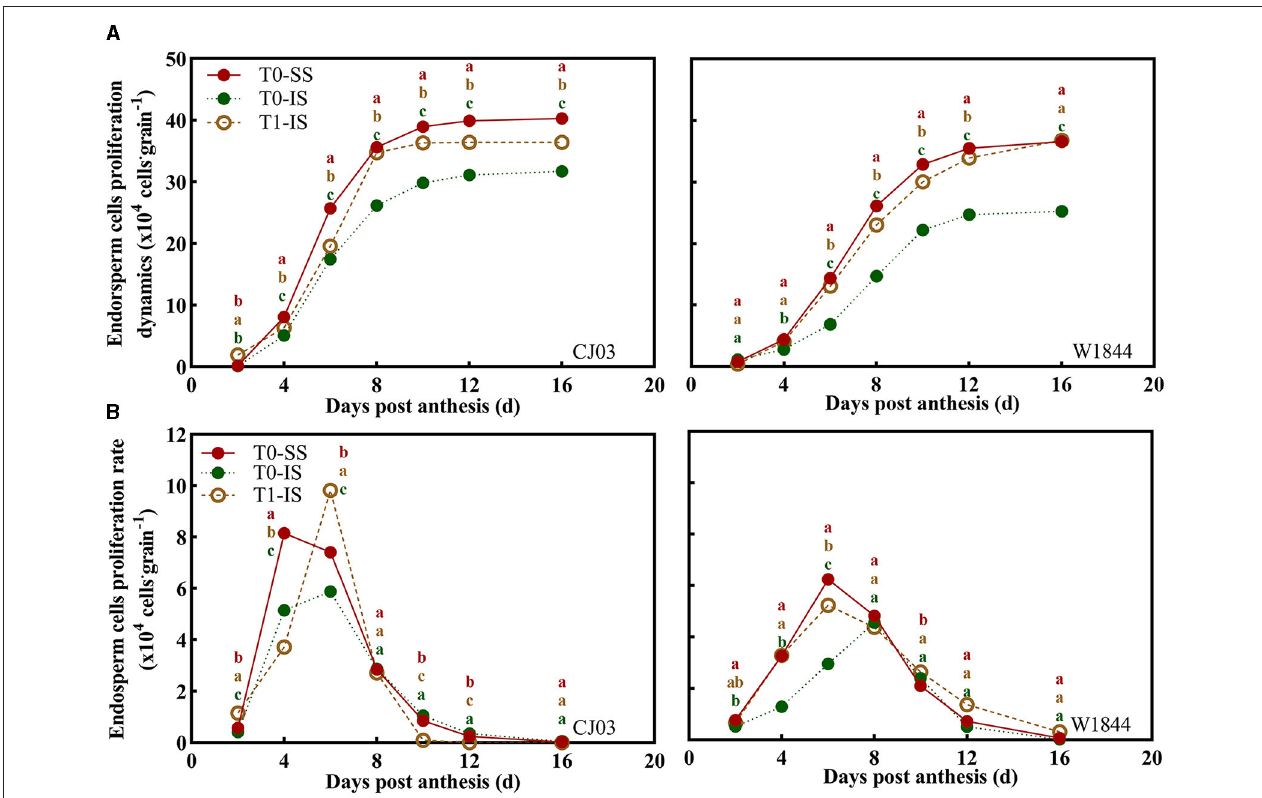
FIGURE 3 | Proliferation changes of endosperm cells in the developing grains of CJ03 and W1844. The T0-control group without any treatment; T1-top 2/3 of the spikelets were removed. (A) , the proliferation dynamics of endosperm cells in the test materials during the early grain filling period under spikelet-removing treatments.